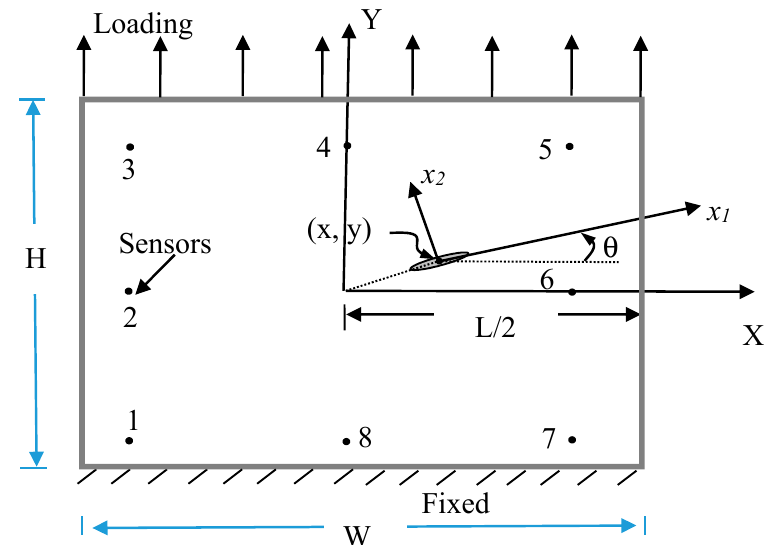
Figure 1. Loading and fixed conditions of a hole in the square composite plate and the sensor positions (no. 1~8).